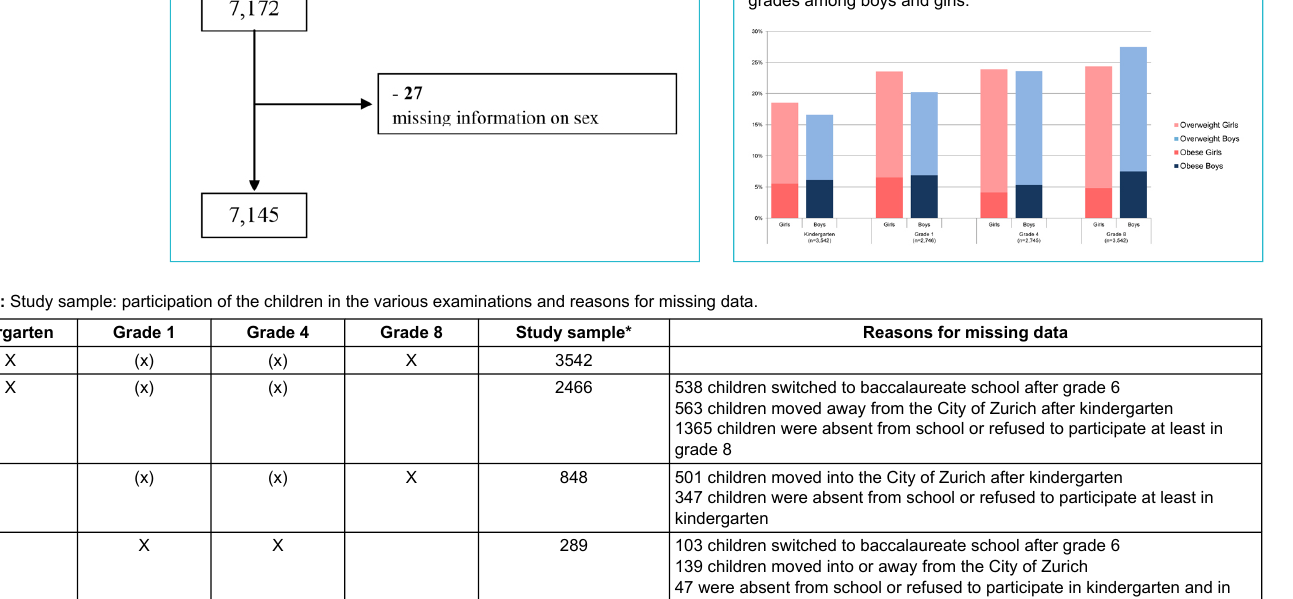
Figure 2: Prevalence of overweight/obesity in different school grades among boys and girls.